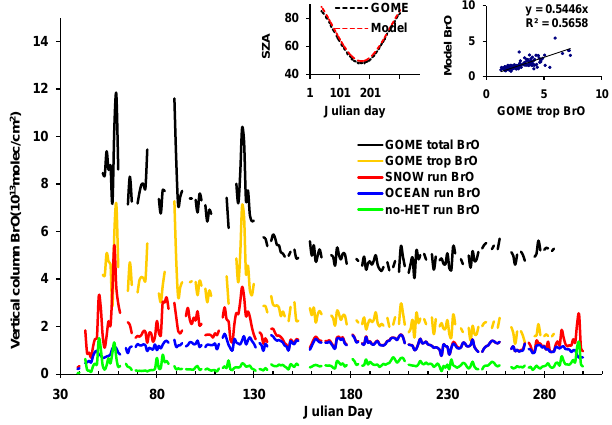
Fig. 3. Comparisons of modeled tropospheric column BrO (red) with GOME total vertical column BrO (black) and retrieved tropo- spheric BrO (yellow) over Barrow (73 ◦ N, 157 ◦ W) for year 1998. The model experiments, the OCEAN and noHET runs, are shown in blue and green lines, respectively. The inset plot (left) shows solar zenith angle (SZA) of the model output (red) and satellite observa- tion (black); the inset plot (right) shows the relationship and regres- sion coefficient between retrieved and model tropospheric column BrO (BASE